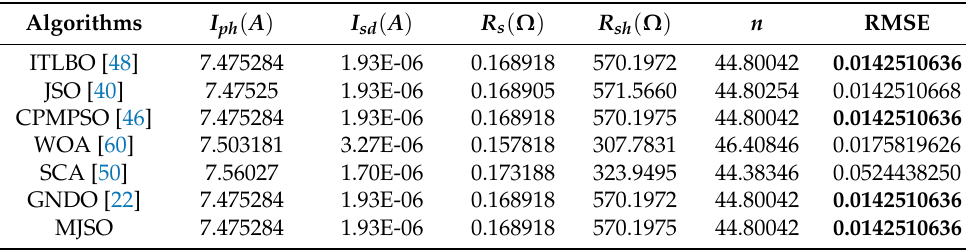
Table 12. Comparison on the STP6-120/36 in terms of extracted parameter and the corresponding RMSE.